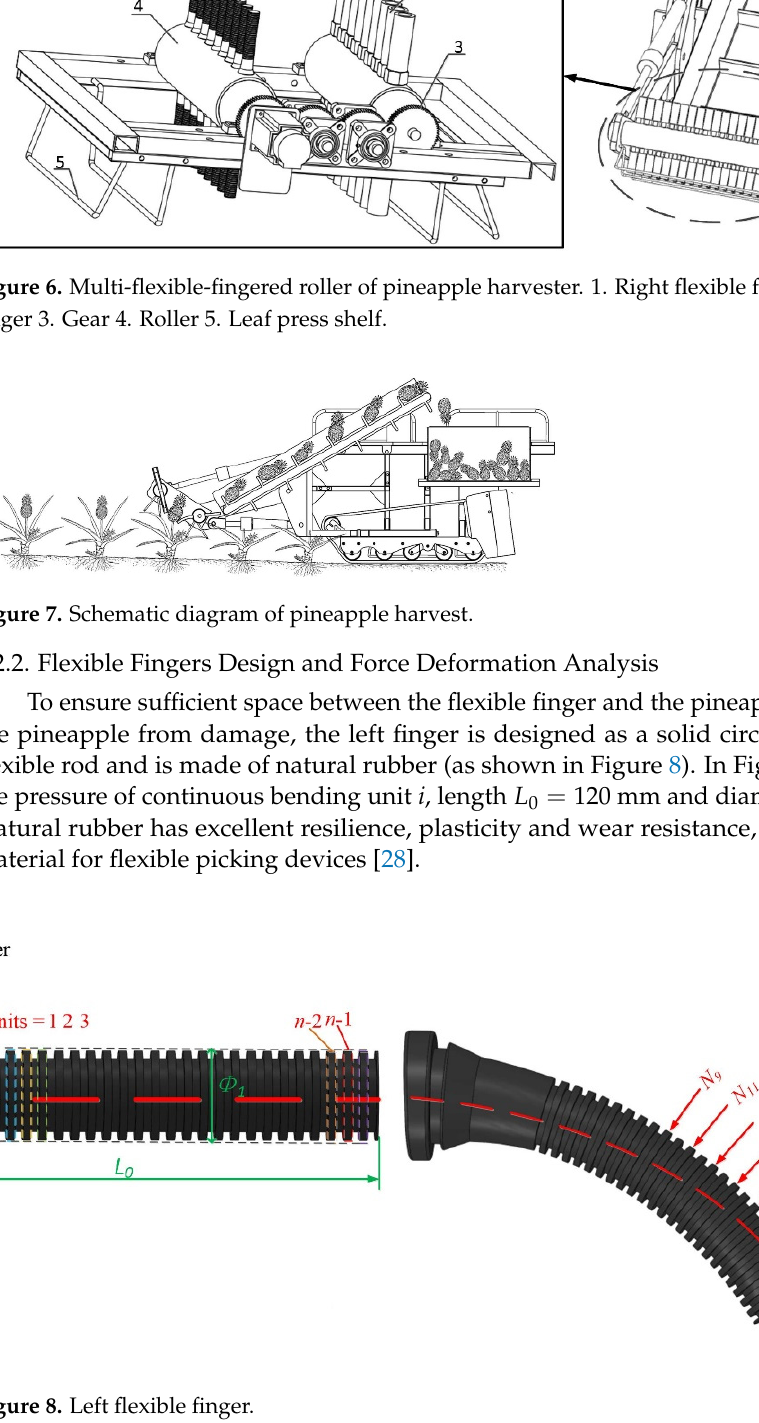
Figure 9. Right flexible finger. Figure 10. Pseudo-rigid-body model.